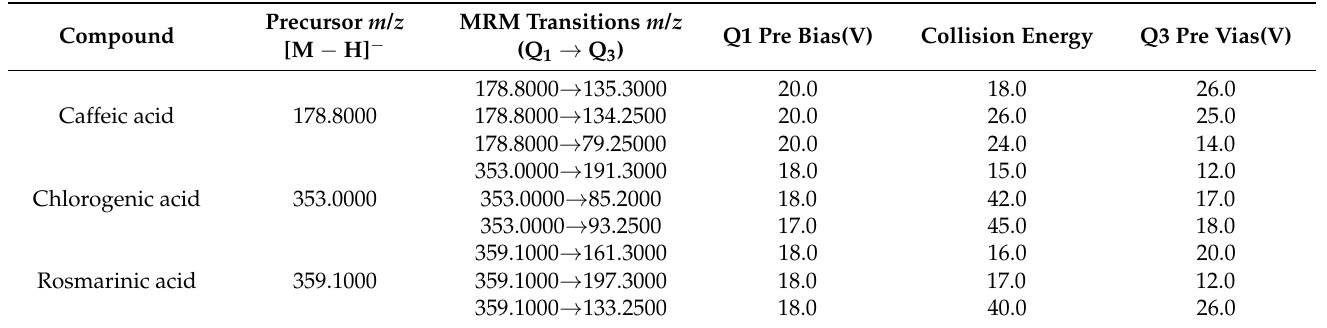
Table 6. Parameters for marker compound quantification by MRM